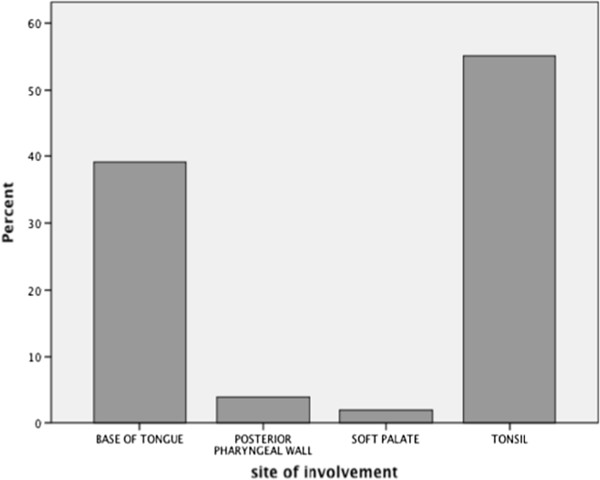
Percentage of patients with OPC who presented with base of tongue, posterior pharyngeal wall, soft palate, and tonsil primaries (n = 153).